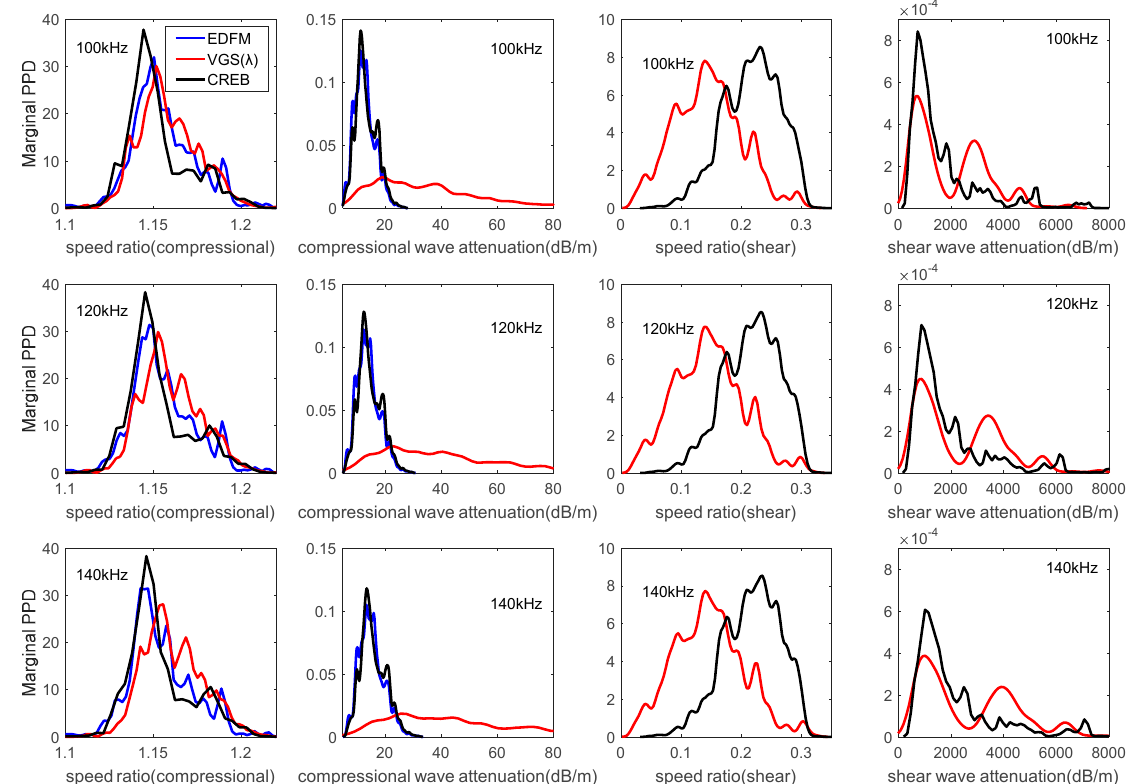
Figure 10. Comparison of uncertainties of ratios of compressional and shear sound speed in sediment to compressional sound speed in water and corresponding attenuation.